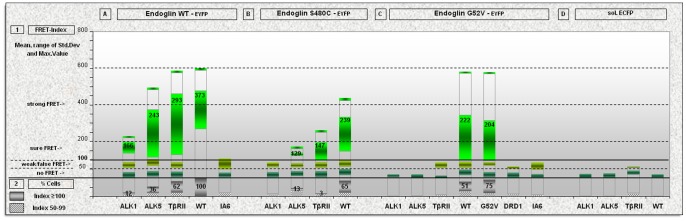
FRET analysed degree of protein interactions between endoglinwt, mutant S480C, mutant G52V, and TGF-β receptors ALK1, ALK5, and TβRII.CHO cells were transfected with the different ECFP-tagged membrane receptors and co-transfected either with A. endoglin wild-type (EYFP-tagged), B. with the mutant S480C (EYFP-tagged), or C. with the mutant G52V (EYFP-tagged). D. Soluble cytoplasmic ECFP co-transfected with EYFP-tagged TGF-β receptors served as a general negative control. Cells were seeded in glass dishes suited to fluorescence microscopy and analysed by live cell imaging 24 hours after transfection. A minimum of 30 cells for each analysed protein interaction was evaluated to determine FRET indices. The diagramme summarises the results for each receptor combination. (1) Upper part of the diagramme: based on the negative controls, FRET index values were sorted into three groups: Group1: FI<51 (no interaction), Group2: FI 51–99 (no/weak interaction or false positive), Group3: FI≥100 (interactions of different strengths). Distribution of the FRET-index values within the groups is shown within the standard deviation. The mean value is indicated for Group 1 and the maximum is shown graphically. (2) Lower part of the diagramme: frequencies (number of cells in %) of FRET occurrences for the positive group (grey bar) and for the second group (FI 51–99, hatched bar). The value is given for the positive group. Frequencies of Group 3 (FIs<50) are not shown.